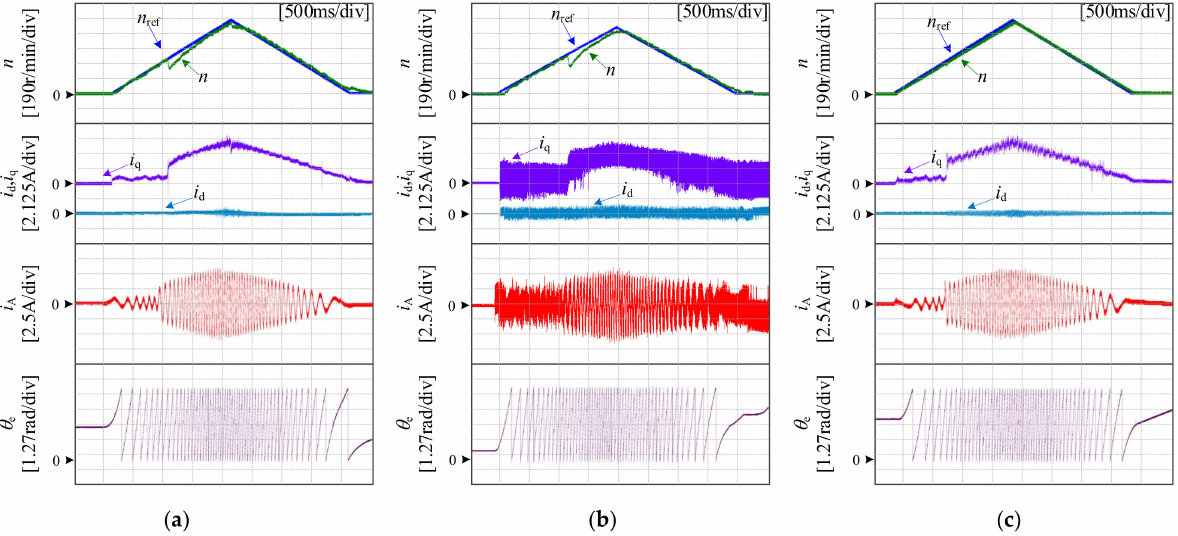
Figure 6. Tracking performance validation with triangular reference signals. ( a ) FOC (with the feedforward and anti-windup link). ( b ) PI-PCC. ( c )